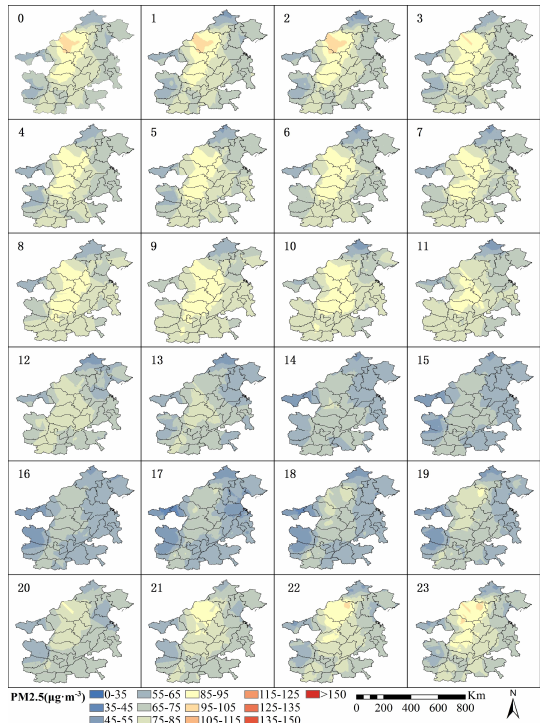
Figure 5. Spatial distribution of hourly PM2.5 concentration in the “2+26” cities